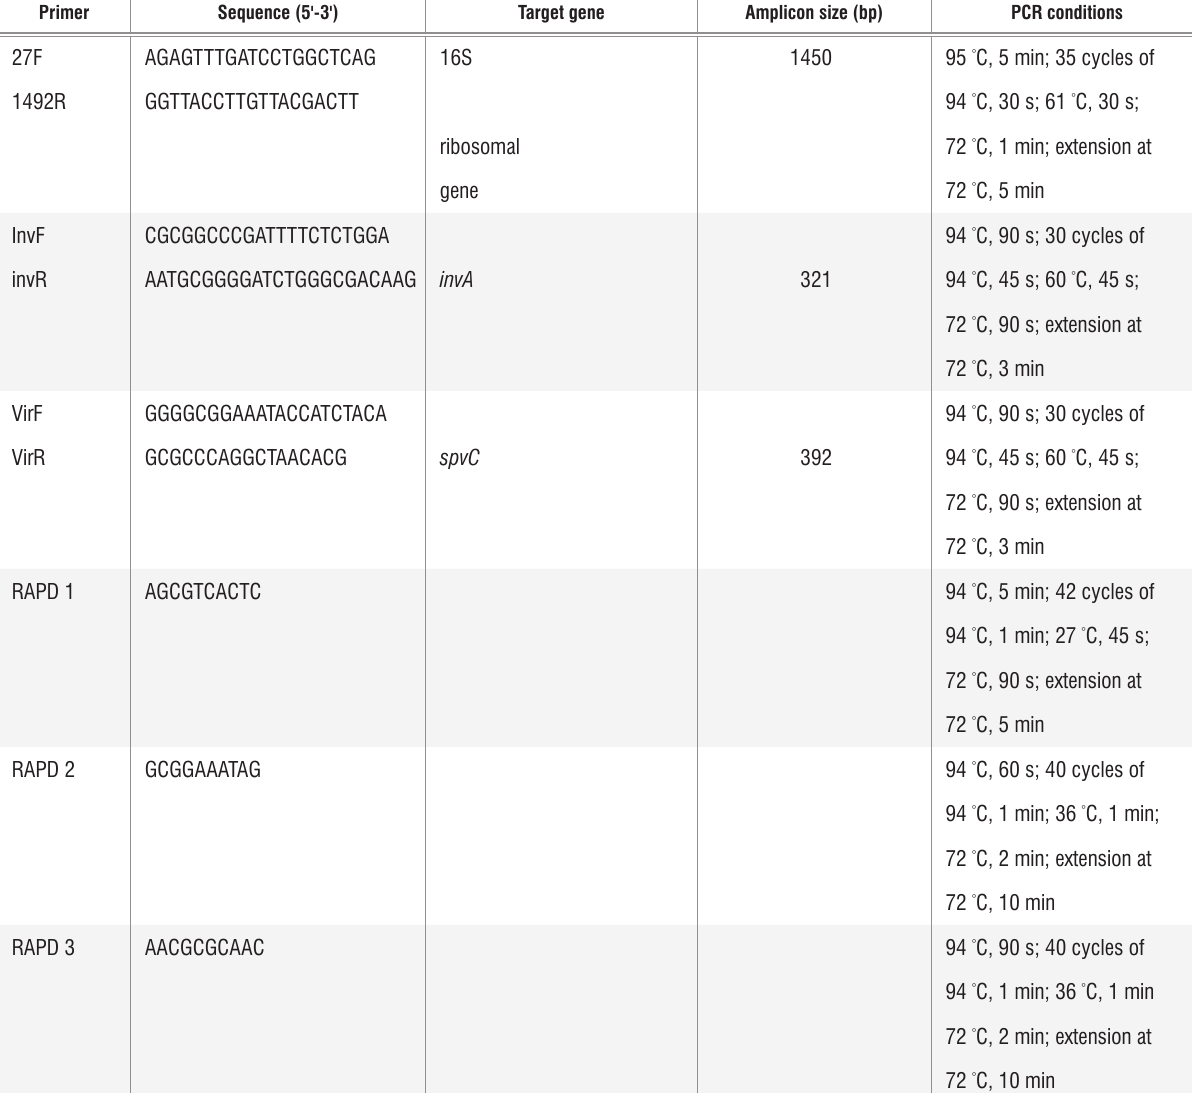
Table 2: Primers and polymerase chain reaction (PCR) conditions used for amplification of target genes and random amplified polymorphic DNA ( RAPD)-PCR